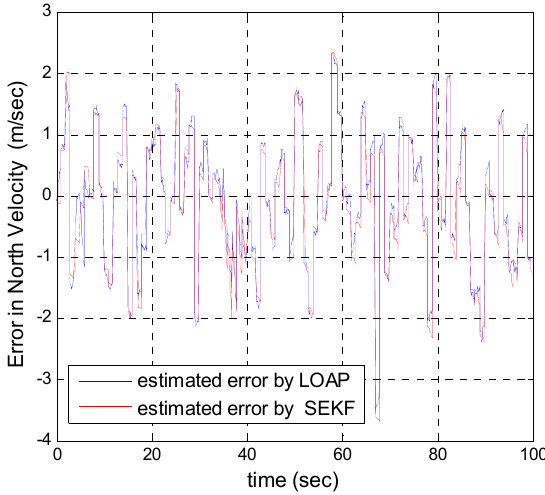
Figure 7. Error estimation of north velocity.